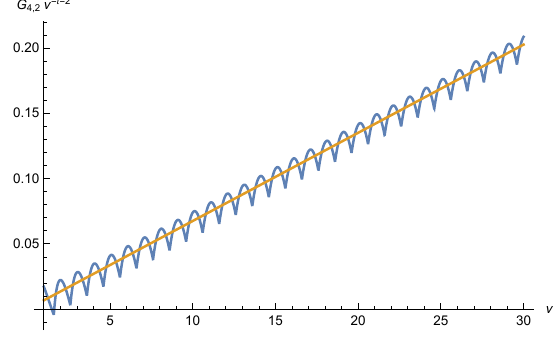
Figure 15 . Subleading Correction for G 4 ; 2 of the Veneziano amplitude. We subtract the leading (cid:23) 2 tail from 1 G 4 ; 2 and compare the subleading correction (cid:23) to the one predicted by (7.11). We (cid:23) 2+ t set as above t = 1 :